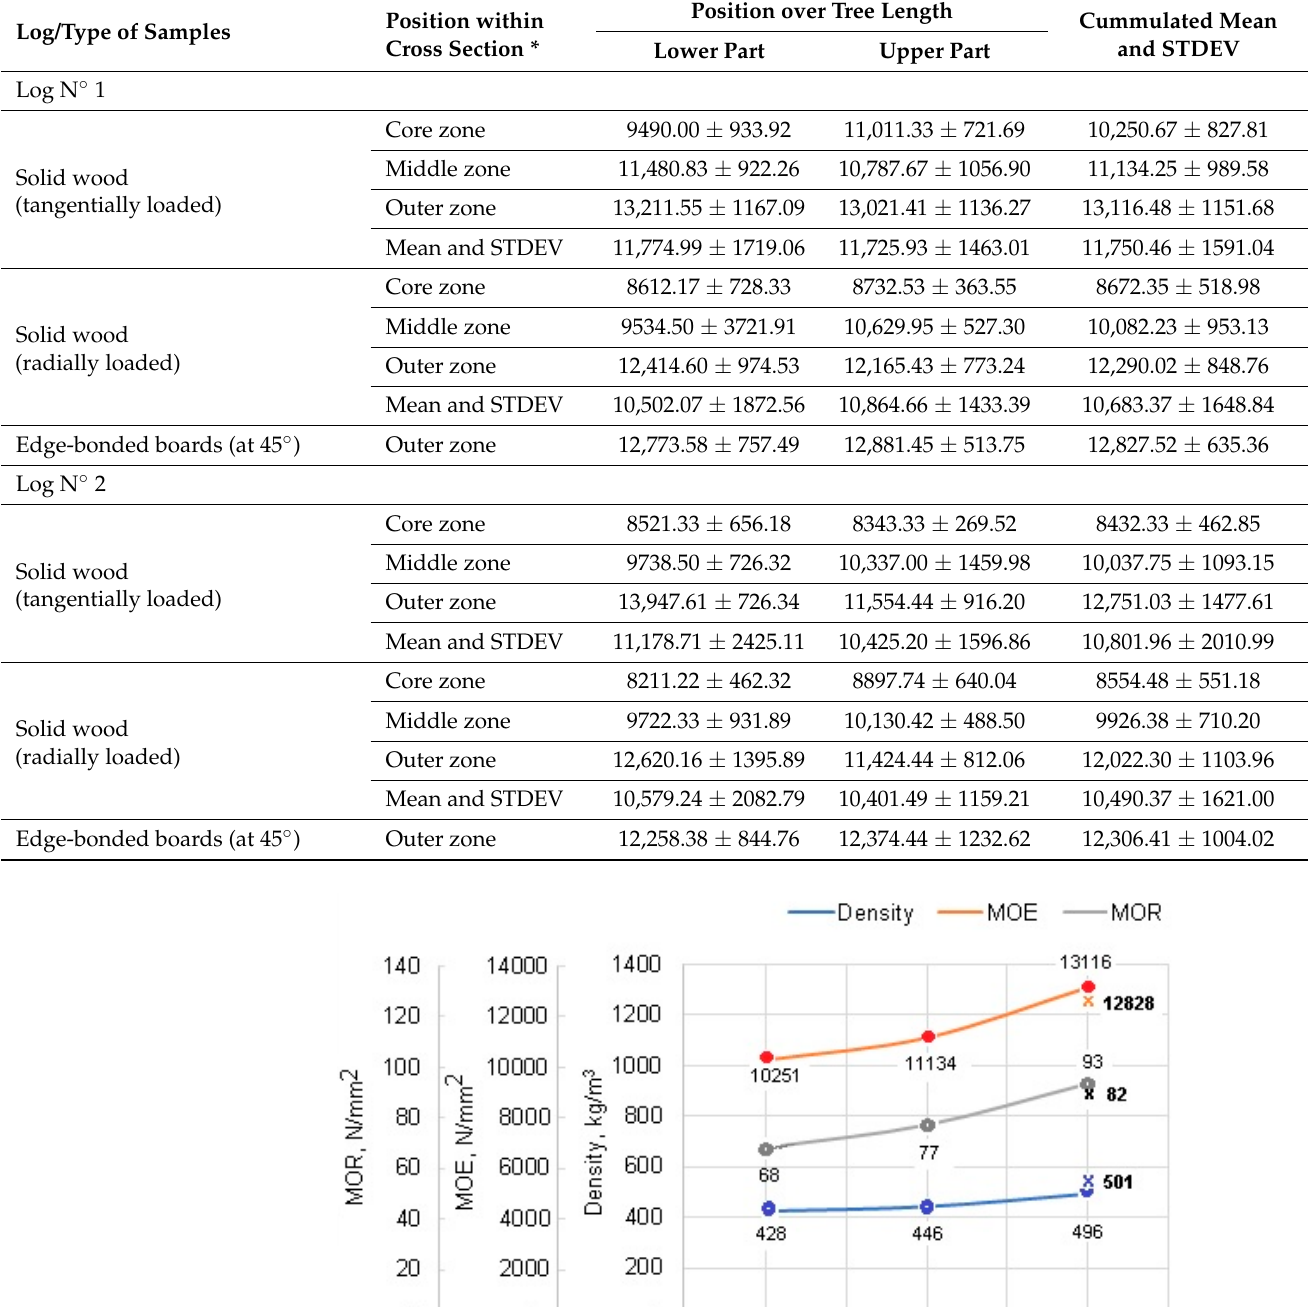
Table 4. Modulus of elasticity in static bending MOE 12 (in N/mm 2 ) of solid and glued spruce samples.